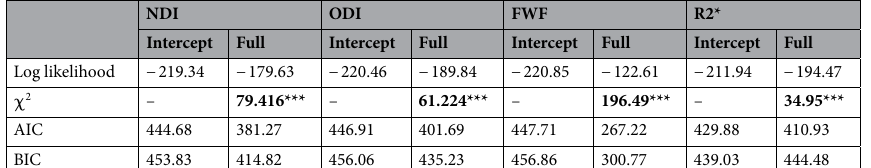
age in the anterior–superior subunit, whereas microstructure in the other subunits was not significantly associ- ated with age (Table 3, Fig. 1). Hence, our results suggest that all hypothalamic subunits are distinguishable by measures reflecting neurite density, dendritic dispersion, free water content, and iron content. However, only dendritic dispersion predominantly in the anterior–superior subunit undergoes age-associated changes. Influence of long‑term stress on anterior–superior microstructure. In this study, hair cortisol and waist circumference were treated as proxies for HPA axis dysfunction, suggesting long-term stress and obesity. The microstructural parameters FWF and R2* are related to tissue water and iron content and were used to